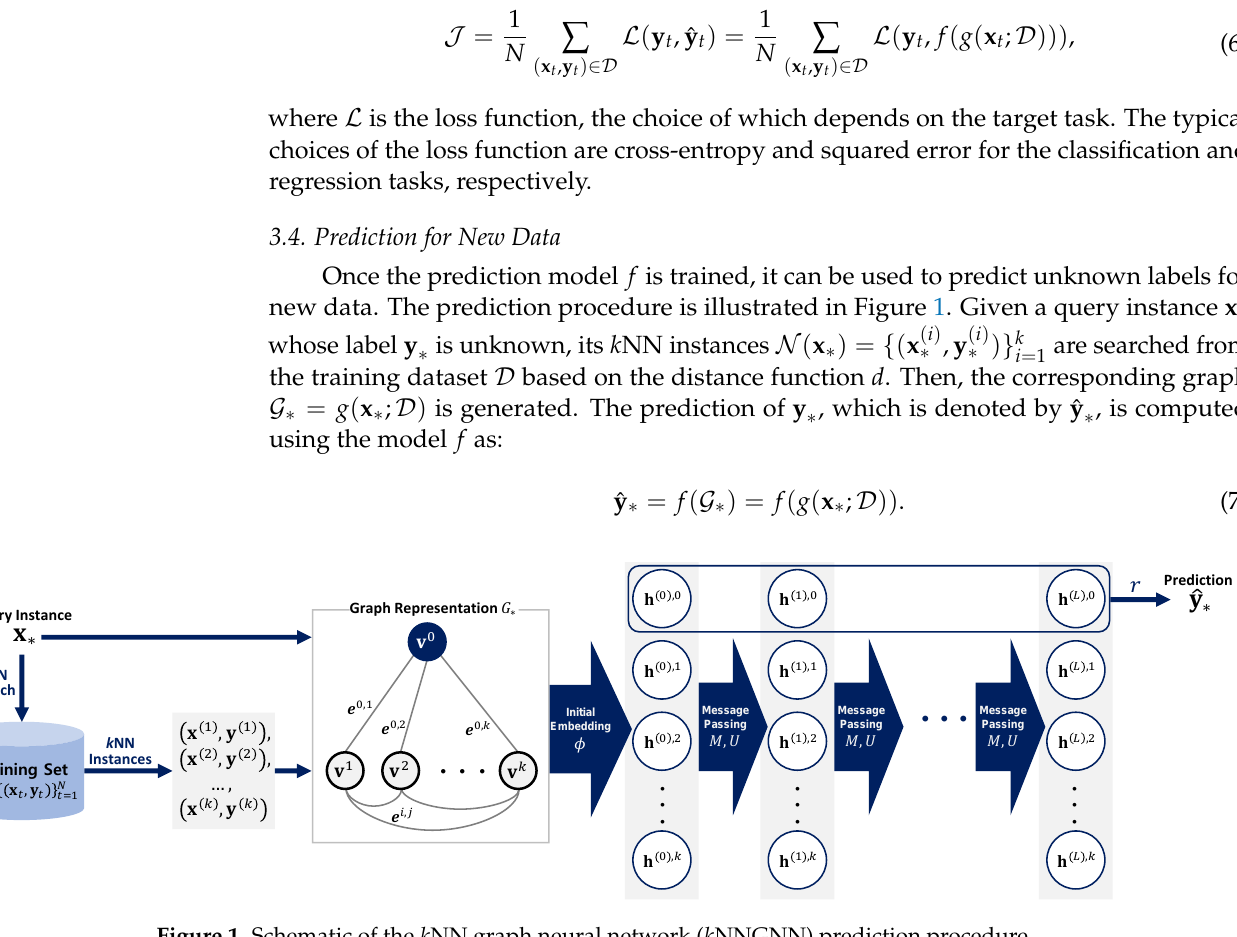
Figure 1. Schematic of the k NN graph neural network ( k NNGNN) prediction